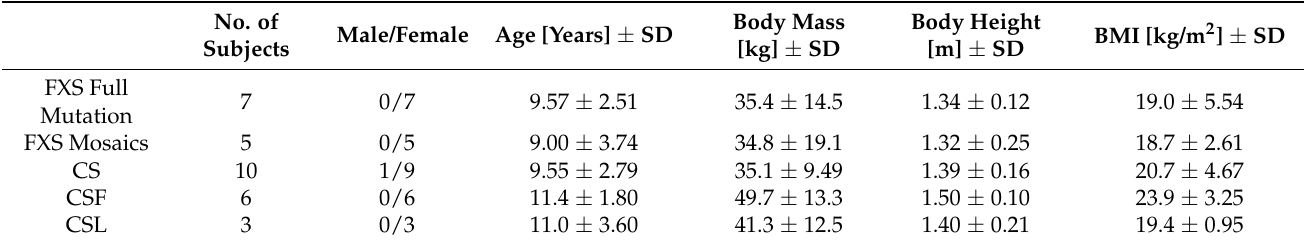
Table 1. Demographic characteristics of the studied subjects: 12 FXS children, of whom 7 carried a classical full mutation of the FMR1 gene (FXS Full Mutation) and 5 a full mutation with mosaicism (FXS Mosaics); 10 controls without any foot deformities or presence of ligamentous laxity (CS), 6 controls with a flat foot (CSF) and 3 controls with ligamentous laxity